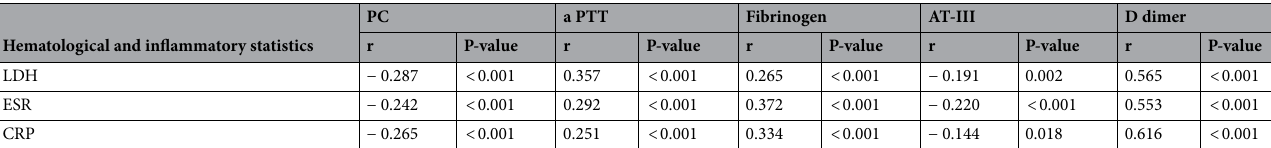
Table 3. Correlation between coagulation parameters and inflammatory markers in severe group. LDH lactate dehydrogenase, ESR erythrocyte sedimentation rate, CRP C-reactive protein, PC prothrombin concentration,